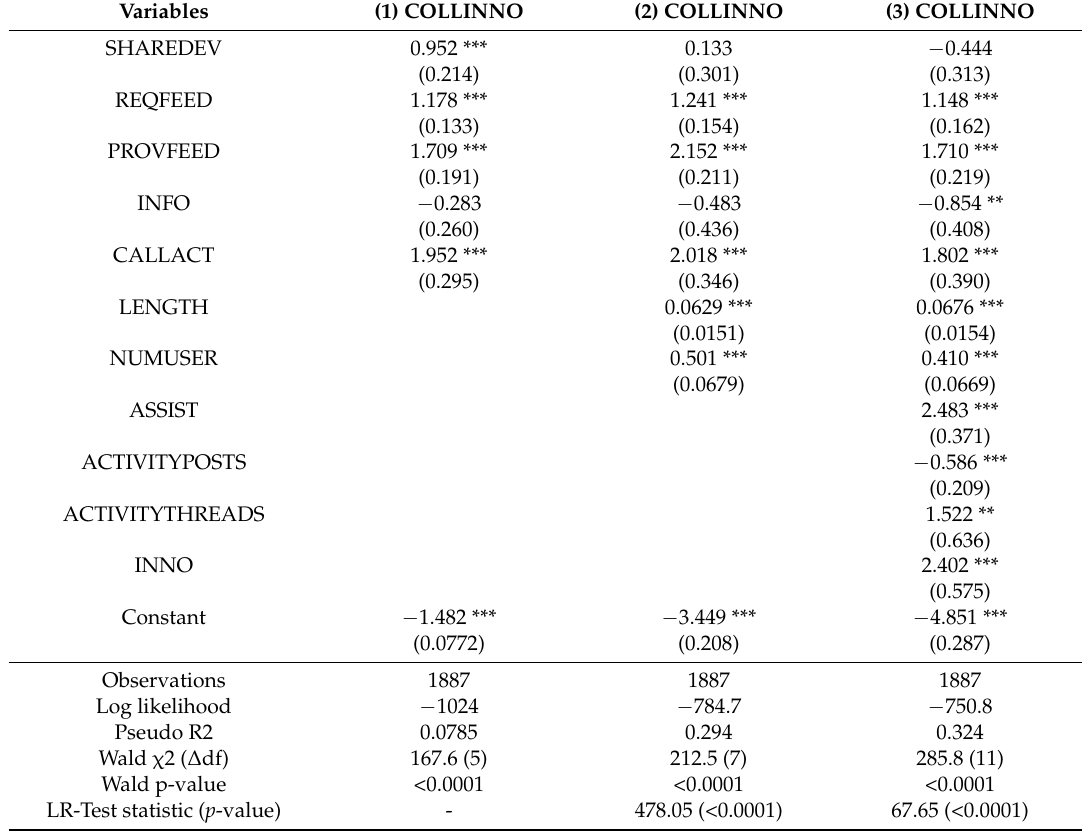
Table 3. Logit regressions of the collaborative